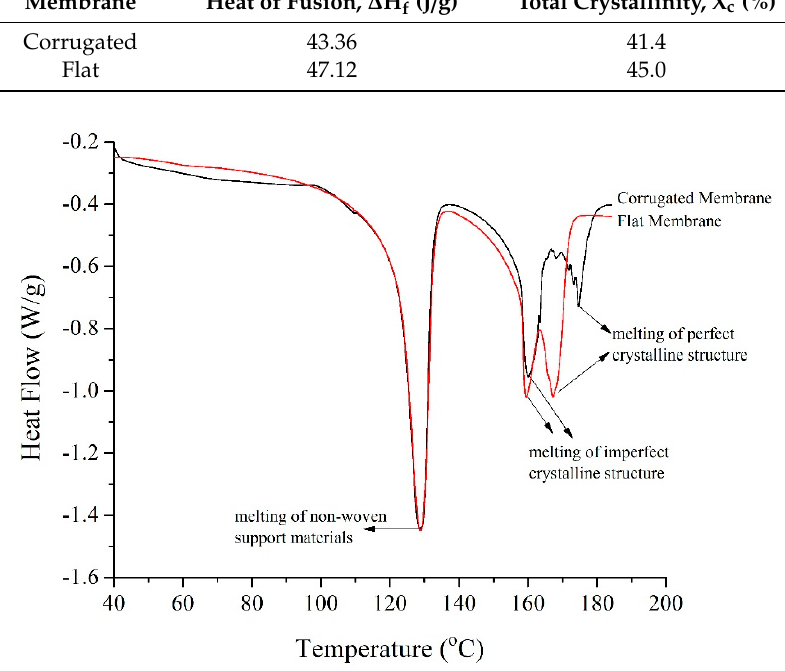
Figure 6. Di ff erential scanning calorimeter curve of the developed Figure 6. Differential scanning calorimeter curve of the developed membranes.